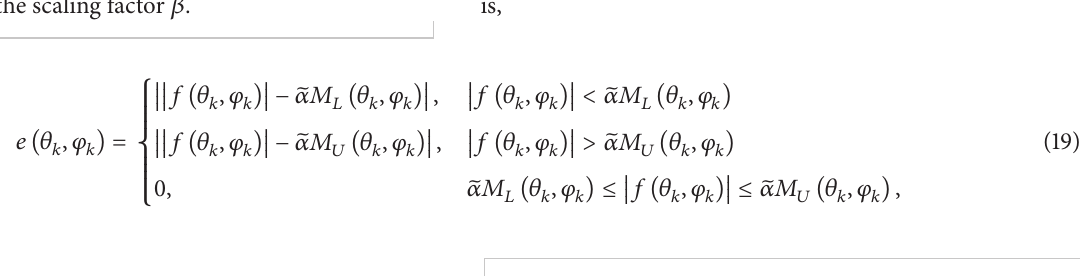
Algorithm 2 (iterative procedure for optimum excitation ̃𝛽 scaling factor